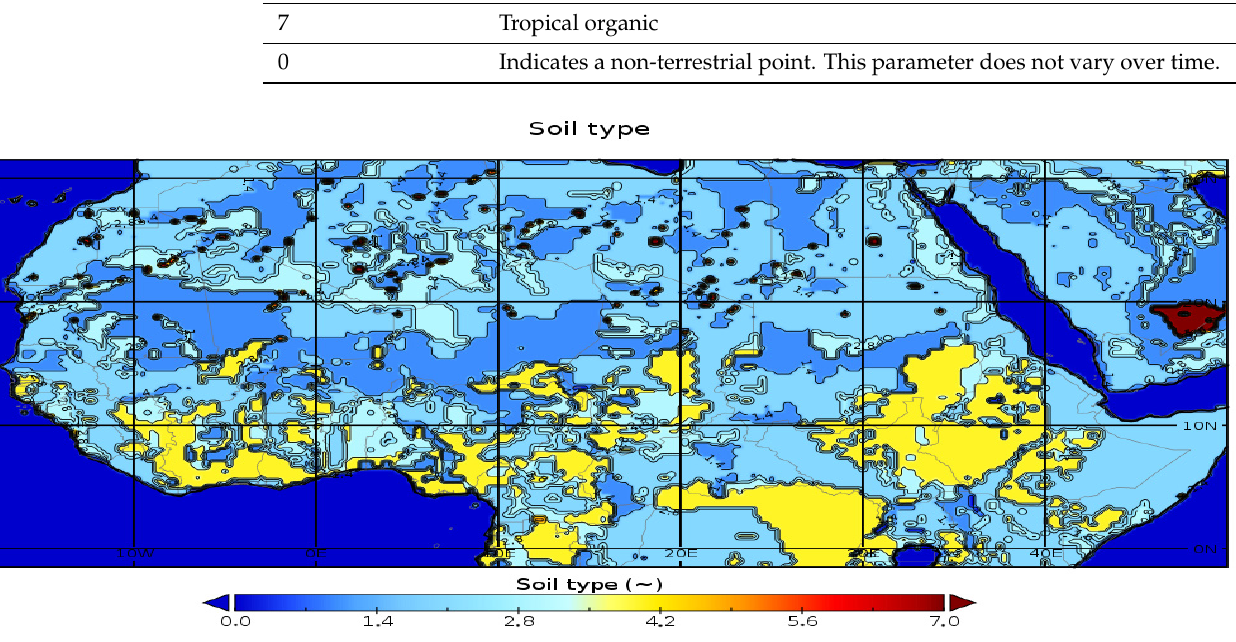
Figure 13. Climatology of soil types (4D-Var ERA5) from 1979 to 2008 with a resolution of 0.5 × 0.5 degrees. Data taken from the ERA5 platform.